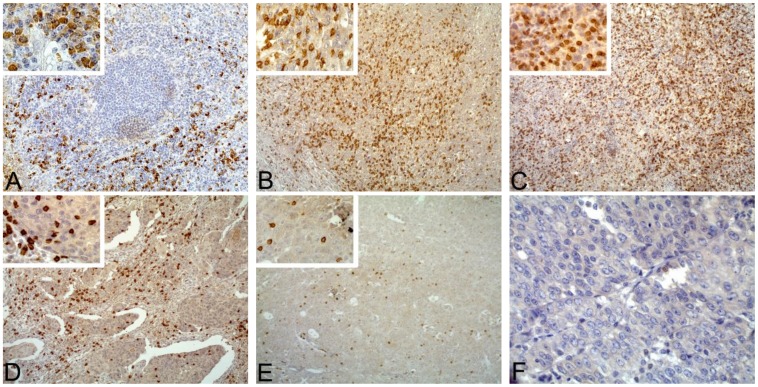
Representative examples of CD8+ CTLs immunostaining in a positive control and breast cancer.A: Normal human tonsil tissue, strong CD8+ CTLs positive infiltrate was mainly distributed in the parafollicular area (original magnification: 100-fold; inset: 400-fold). B: Strong CD8+ CTLs positive infiltrate in invasive breast cancer (CD8+ CTLs positive infiltrate score: 3+) (original magnification: 100-fold; inset: 400-fold). C: Strong CD8+ CTLs positive infiltrate in medullary breast cancer (CD8+ CTLs positive infiltrate score: 3+) (original magnification: 100-fold; inset: 400-fold). D: Moderate CD8+ CTLs positive infiltrate (CD8+ CTLs infiltrate score: 2+) (original magnification: 100-fold; inset: 400-fold). E: Weak CD8+ CTLs positive infiltrate (CD8+ CTLs positive infiltrate score: 1+) (original magnification: 100-fold; inset: 400-fold). F: CD8+ CTLs negative breast cancer (original magnification: 400-fold).